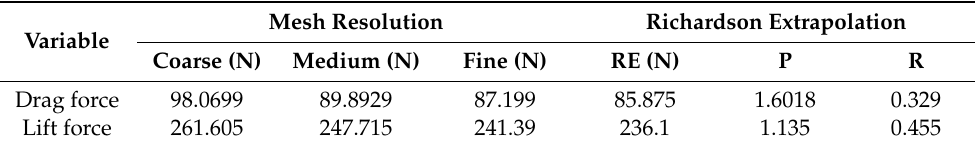
Table 3. Mesh verification for Reynolds-Averaged Navier-Stokes